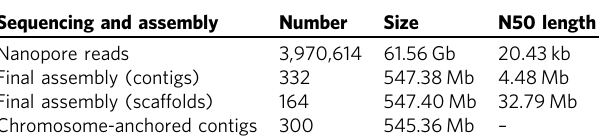
Table 1 Sequencing and assembly statistics of the Chinese wild rice genome.